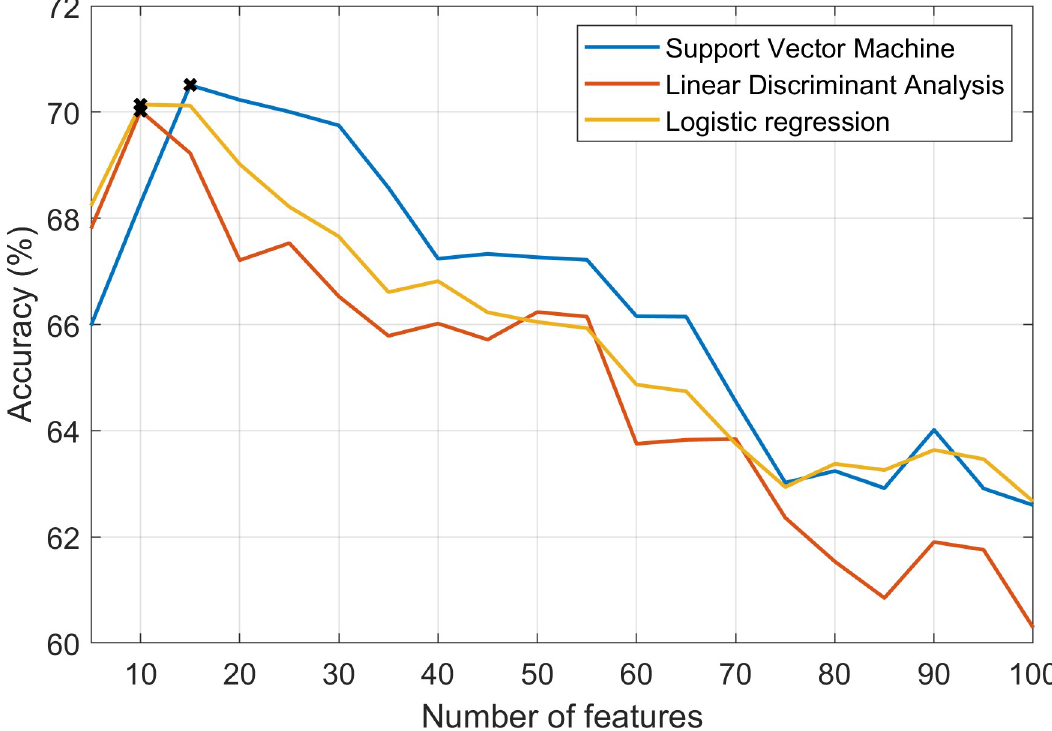
Fig 6. Accuracy plotted for 5–100 features selected with the mRMR algorithm and using the Support Vector Machine classifier, logistic regression and linear discriminant analysis. The highest result for each classifier is marked with an x.